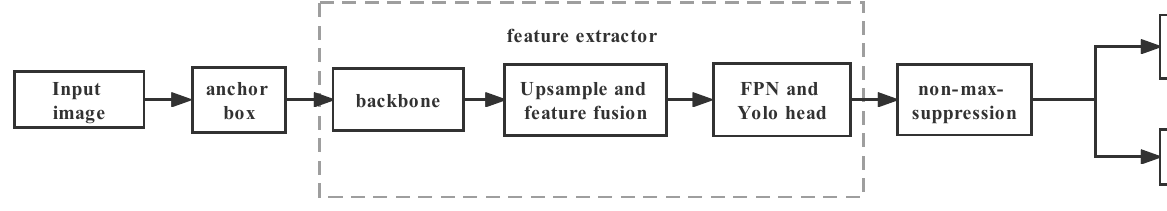
Figure 2. The detection process of